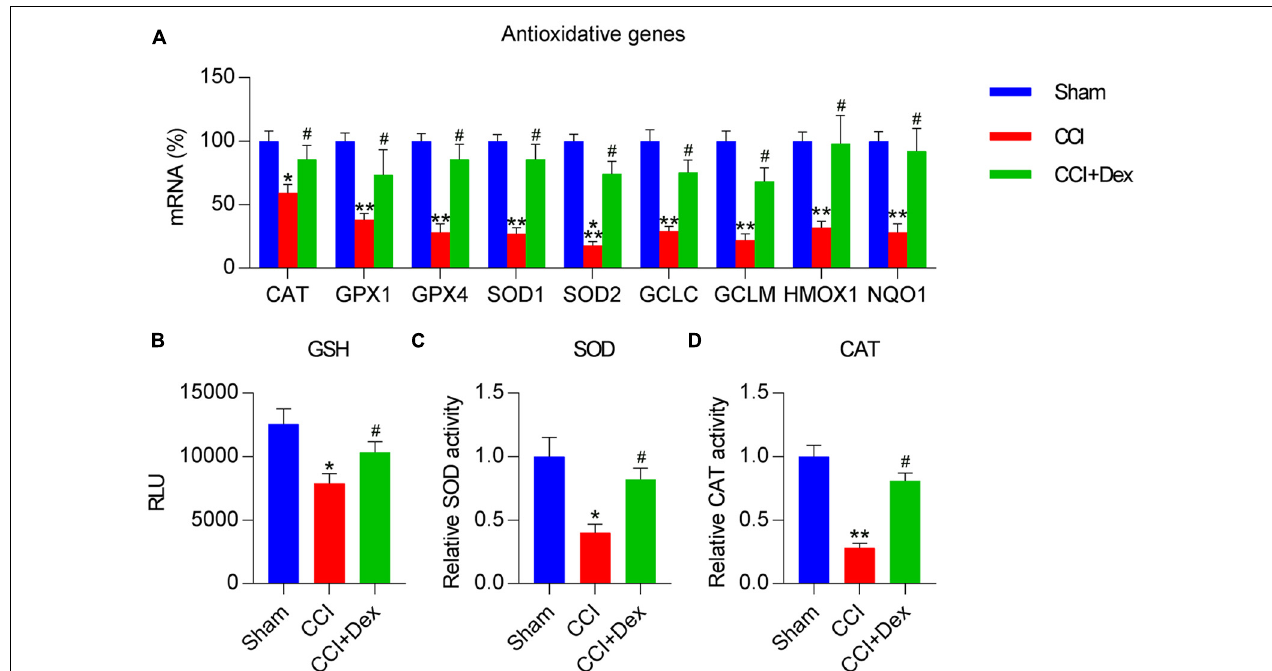
FIGURE 2 | Dexmedetomidine promoted antioxidant capacity in CCI-induced rats. (A) Expression levels of antioxidant genes were determined using quantitative polymerase chain reaction. (B) Analysis of glutathione (GSH) levels. (C) A superoxide dismutase (SOD) assay kit was used to determine SOD activity. (D) Determination of catalase (CAT) activity in spinal cord tissues. * P < 0.05, ** P < 0.01 vs. Sham group; # P < 0.05 vs. CCI group.